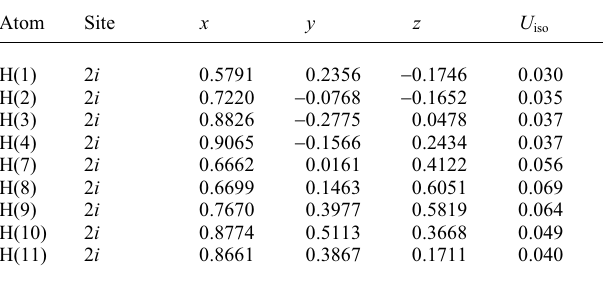
Table 2. Atomic coordinates and displacement parameters (in Å 2 )